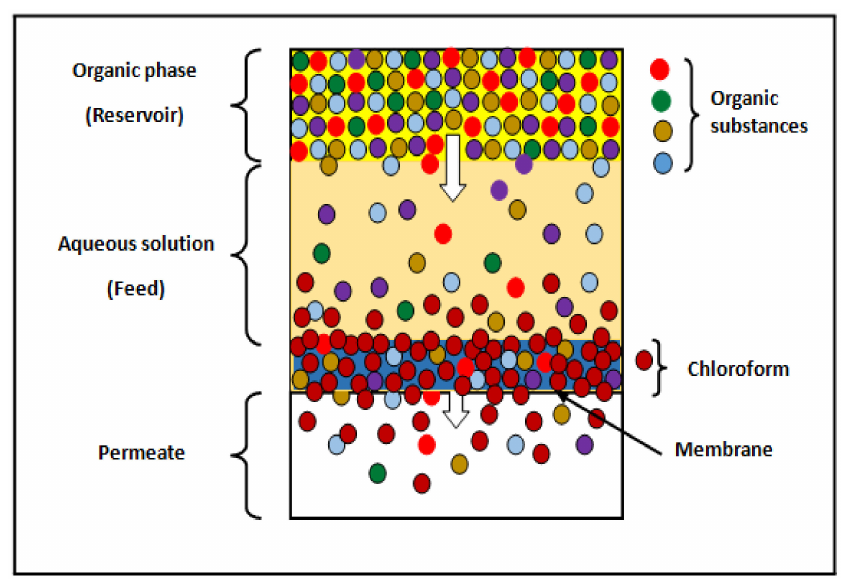
Scheme 3. Mechanism of the stabilization of the concentration of organic substances in the